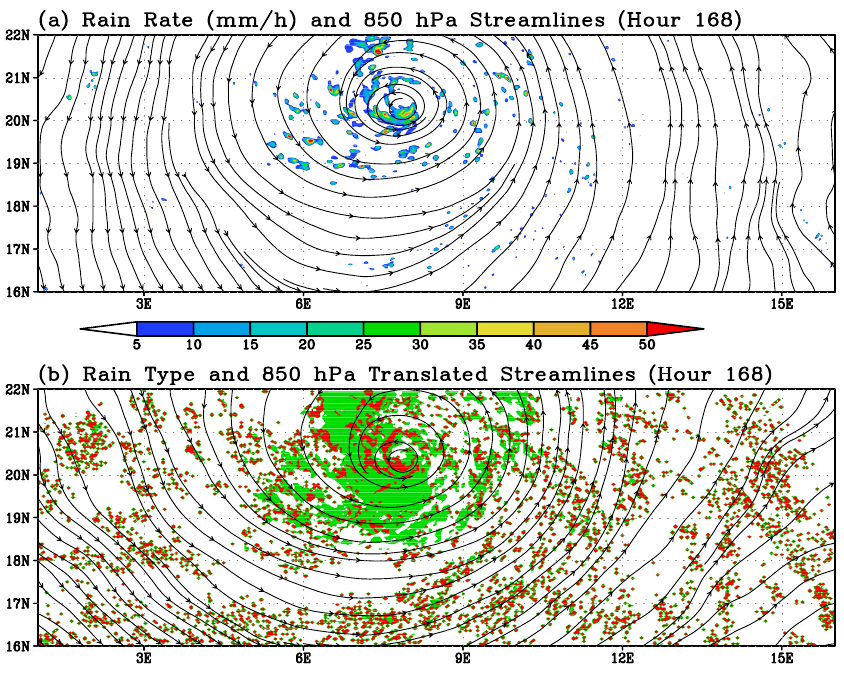
Fig. 20. Snapshot of rain rate (a) and rain type distribution (b) from the ice microphysics run at Hour 168. In (b), green shading represents stratiform precipitation and red represents convective